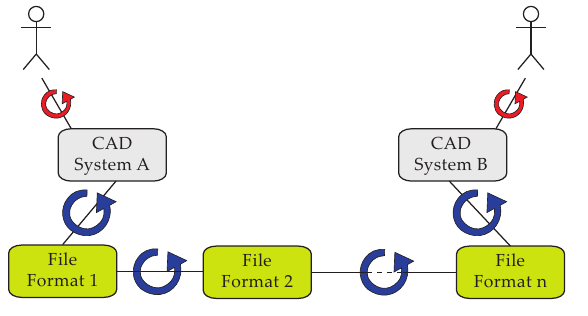
Figure 4. The information flow between two CAD systems using multiple file formats contains multiple interface points (circular arrows) in which information needs to be converted, both between human users and information systems (in red) and among information systems (in blue). The number of interface points depends on the number of file formats